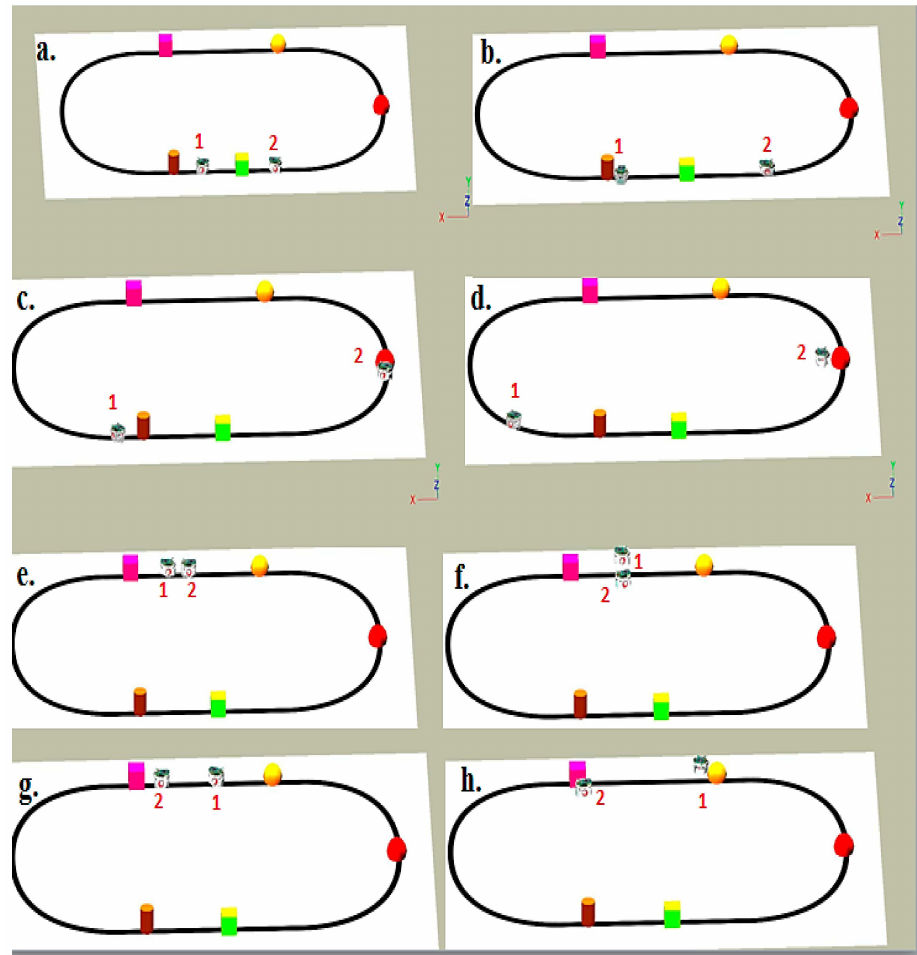
Figure 10. Simulation snapshots for multiple robots and obstacles. ( a ) Both robots at the beginning of the simulation; ( b ) Robot 1 detetcts an obstacle and Robot 2 moves forward; ( c ) Robot 1returns to the line and Robot 2 detects an obstacle; ( d ) Robot 1 continues following the line, and Robot 2 avoids the obstacle and moves around it; ( e ) Robot 1 and 2 detetc each other as dynamic obstacles; ( f ) Both robots avoid each other; ( g ) Both robots have successfully avoided each other and returned to the line; ( h ) Both robots detect other obstacles